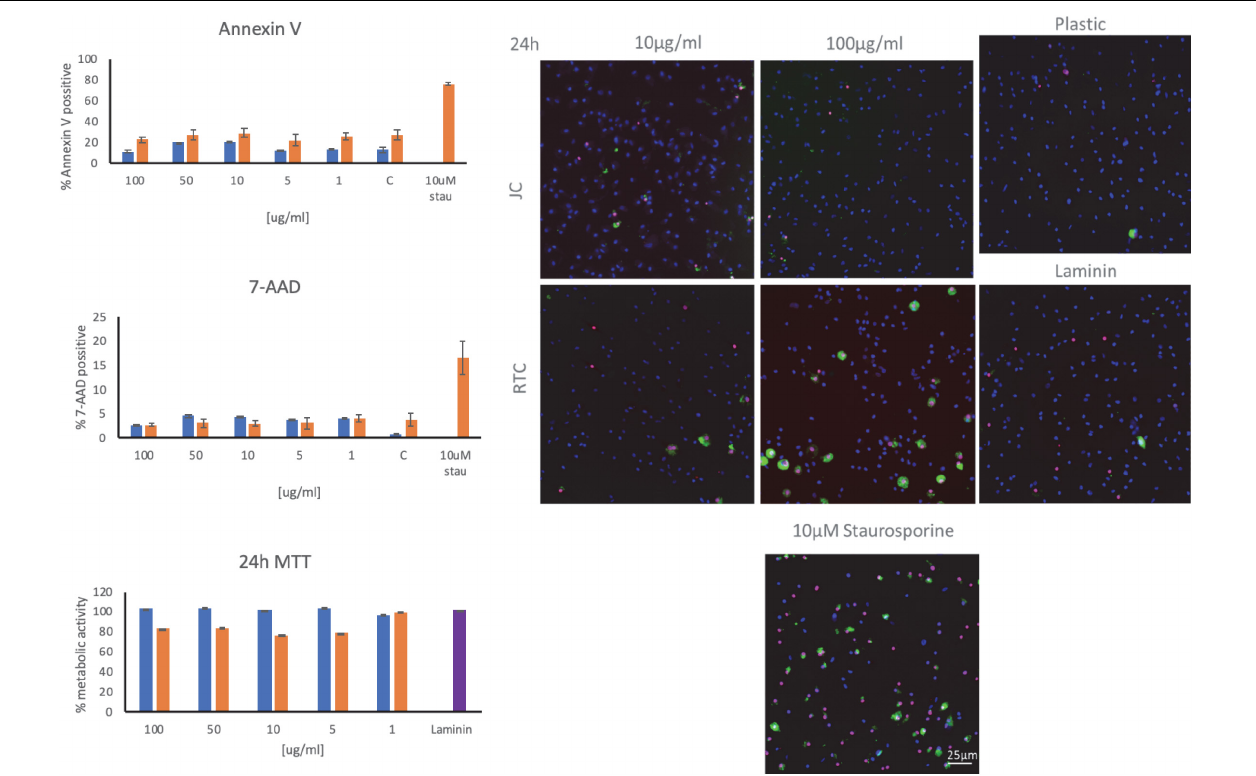
FIGURE 4 | Staining of microglia using annexin V and 7-AAD as markers of apoptosis following culture of microglia on JC, RTC, laminin, or plastic for 24 h. A positive control of cell death was included by incubating cells with 10 µ M Staurosporine for 2 h prior to staining. Blue: DAPI, Green.